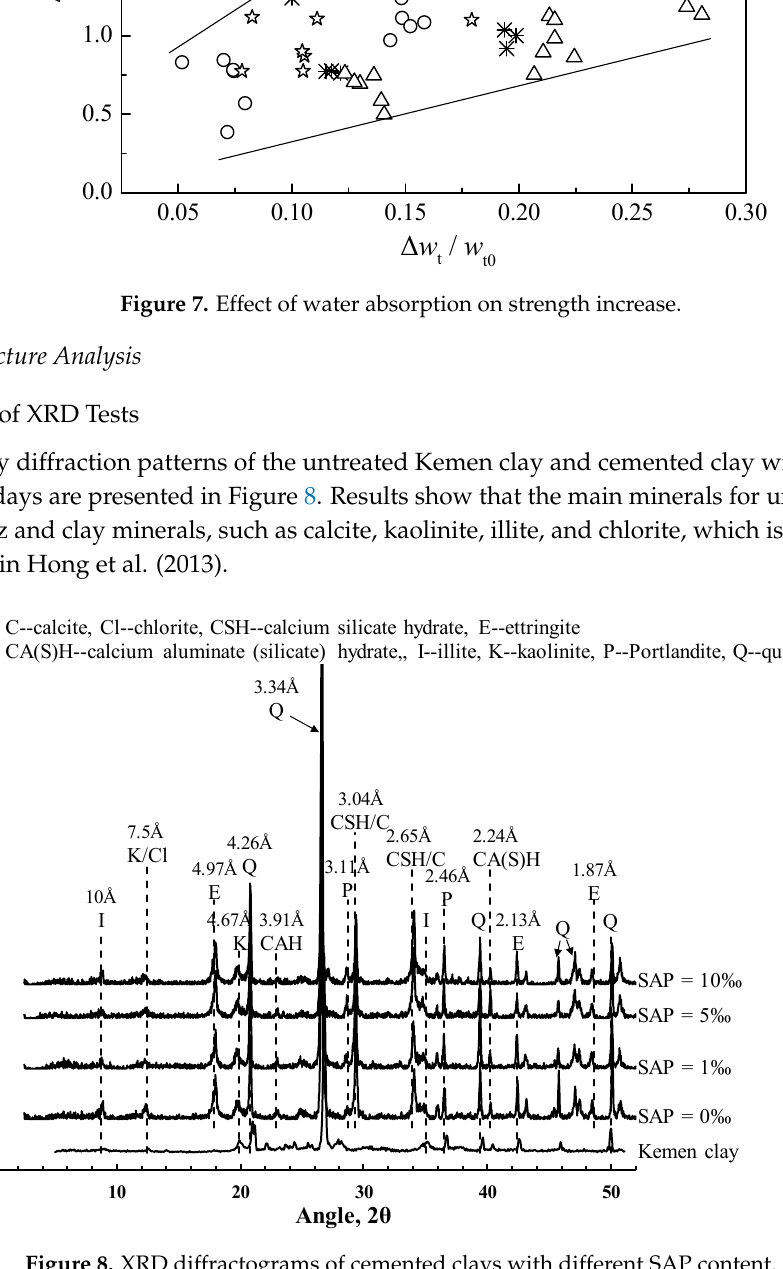
Figure 8. XRD diffractograms of cemented clays with different SAP content.